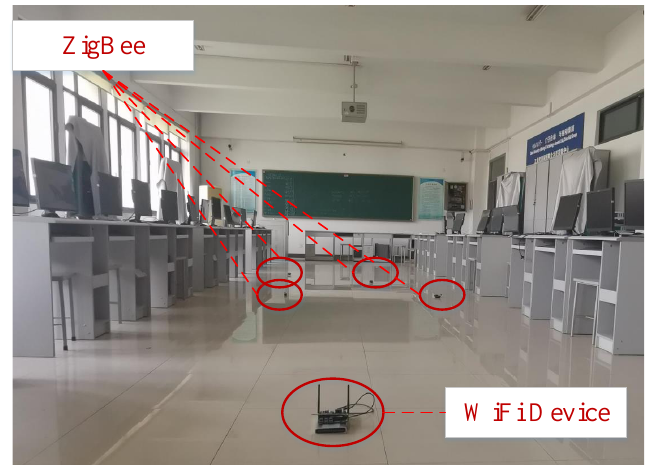
Figure 4. Experimental scene indoor.